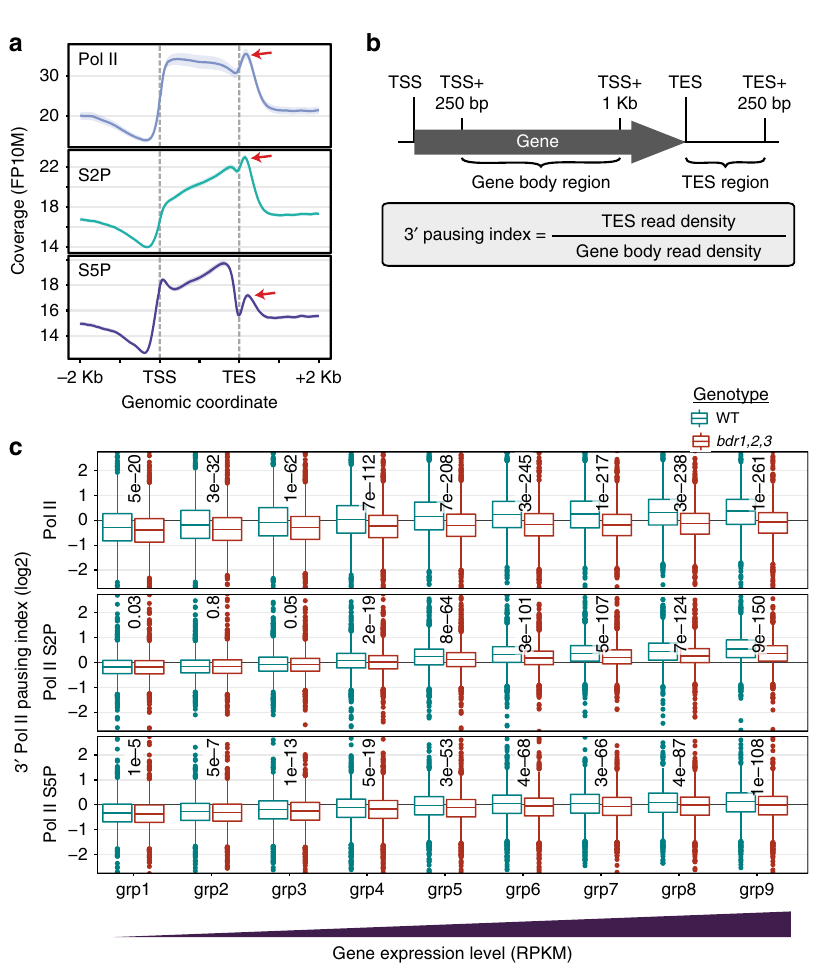
Fig. 4 BDR proteins promote 3 ′ pausing and gene expression in a speci fi c genomic context. a Pol II ChIP-seq coverage across expressed genes in Arabidopsis seedlings. 3 ′ pausing indicated by red arrows. b Calculation of a 3 ′ pausing index. c 3 ′ pausing indices for nine groups of genes de fi ned by increasing mRNA expression levels in wild type. 3 ′ pausing is reduced in the bdr1,2,3 mutant, particularly at highly expressed genes. The centerline of boxplots is the median. The bounds of the box are the fi rst and third quartiles (Q1 and Q3). Whiskers represent data range but are bounded to 1.5-fold the interquartile range (Q3 – Q1); points outside this range are represented